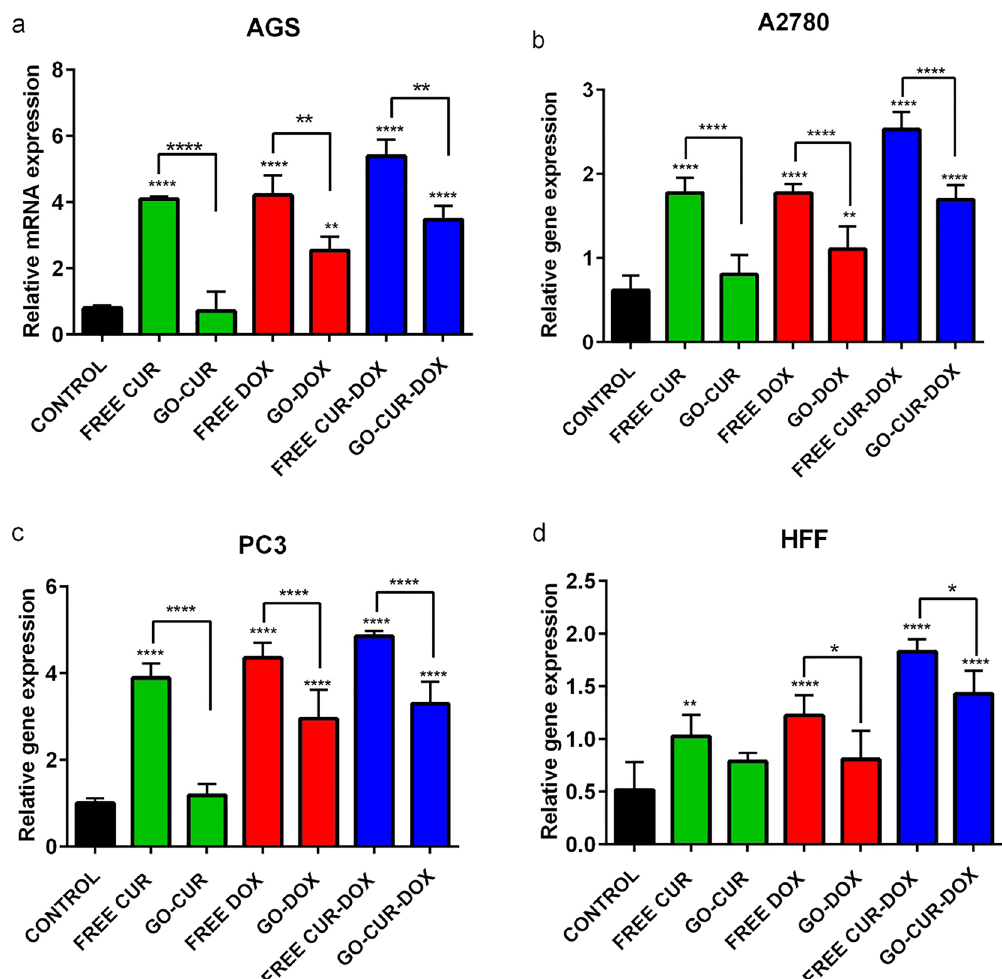
Figure 12. Effect of free CUR, GO-CUR, free DOX, GO-DOX, free CUR-DOX and GO-CUR-DOX on the expression of RB1 in AGS, PC3, A2780 and HFF after 48 h. Results are expressed as the mean ± standard deviation (*p < 0.05) (**p < 0.001) (****p <